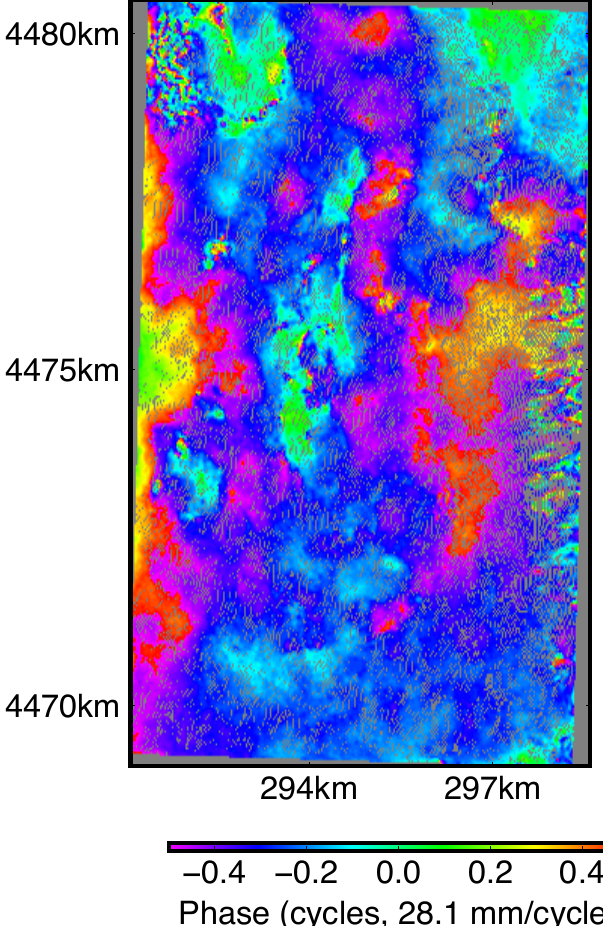
Figure A3. Deformation field at San Emidio in terms of wrapped range change in cycles from an Envisat track 120 pair spanning 11th May 2005 to 20th July 2005. One cycle of wrapped phase corresponds to a range change of approximately 28 mm. Orbital baseline b ⊥ = 201.5 m and temporal baseline ∆ t = 70 days. Coordinates are easting and northing kilometers in UTM projection zone 11N, WGS84